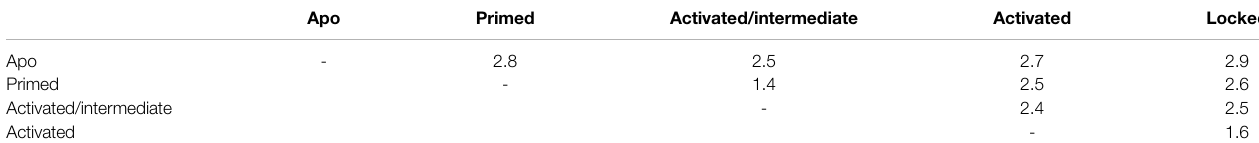
TABLE 4 | C α rmsd in Angstroms for pairs of RyR model channel core models (calculated without the fl exible BL region).